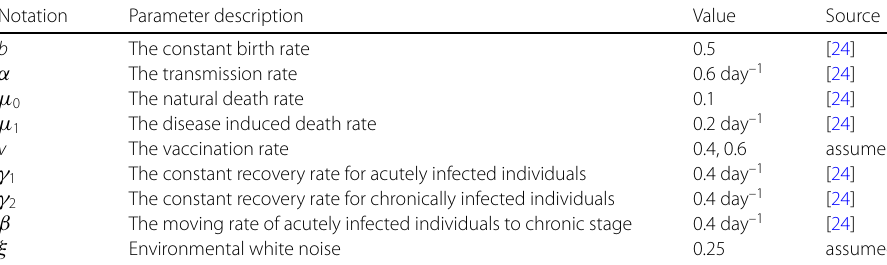
Table 1 Parameters used in the model